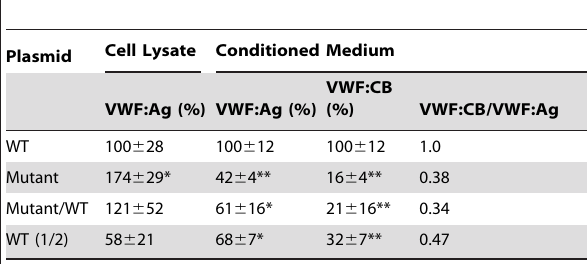
Table 2. Expression of WT and mutant VWF in transfected HEK293